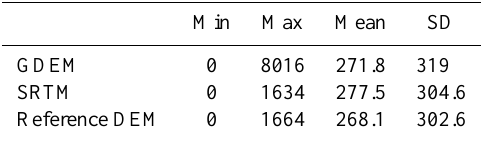
Table 1. General information on the global DEMs and reference DEM (all the negative values were filled by neighboring